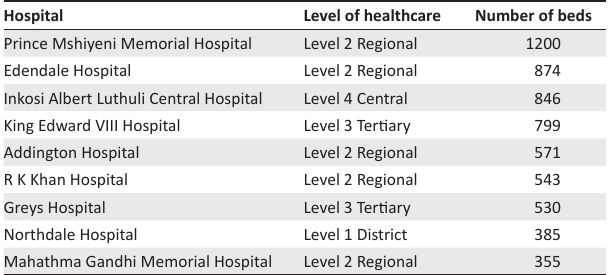
TABLE 1: Public hospitals and bed numbers in KwaZulu-Natal, South